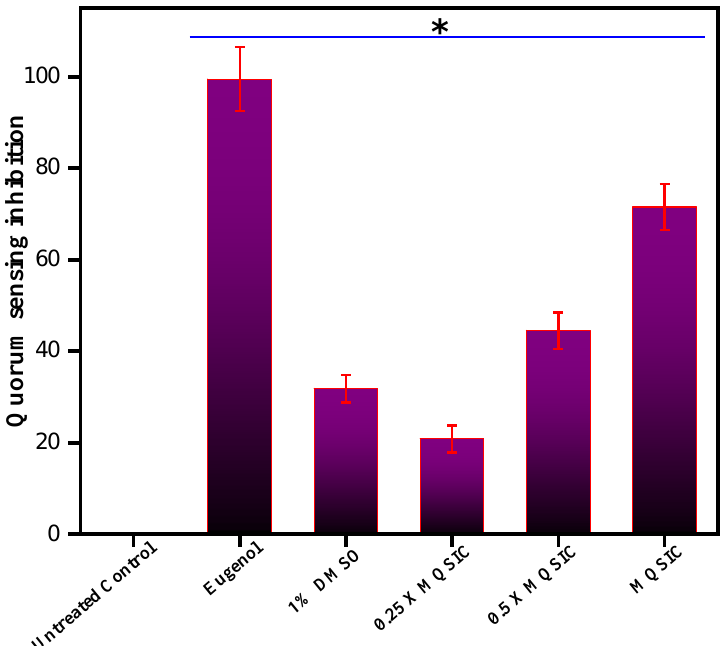
Pharmaceutics 2021 , 13 , 1743 19 of 26